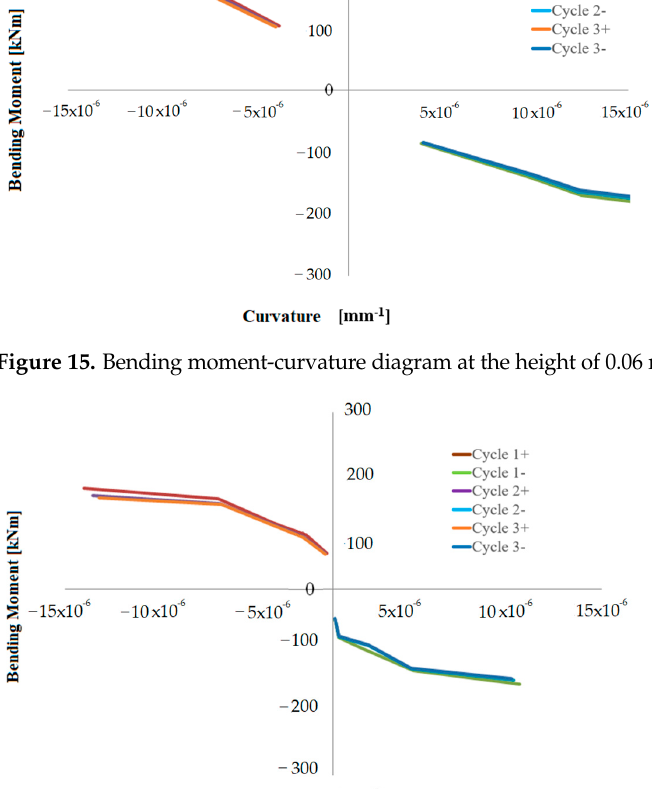
Figure 16. Bending moment-curvature diagram at the height of 0.66 m from the base—rectangular pier.